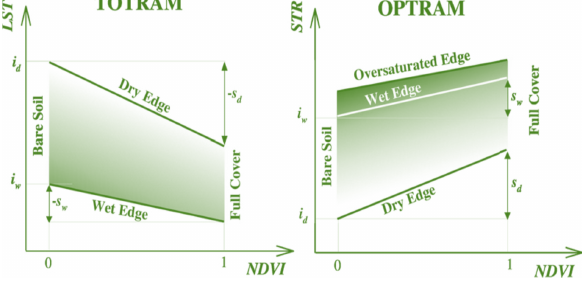
Figure 3: Sketch of OPTRAM and